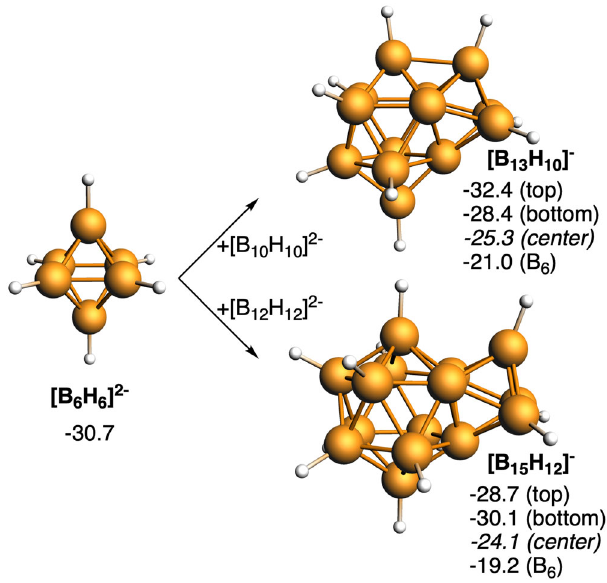
Fig. 5 3D/3D systems formed from the fusion of [B 6 H 6 ] 2 − and [B 12 H 12 ] 2 − or [B 10 H 10 ] 2 − . Computed NICS (in ppm) at the center of different four- and fi ve-membered rings and at the center of each cluster are enclosed. Boron atoms in orange, and H atoms in white.